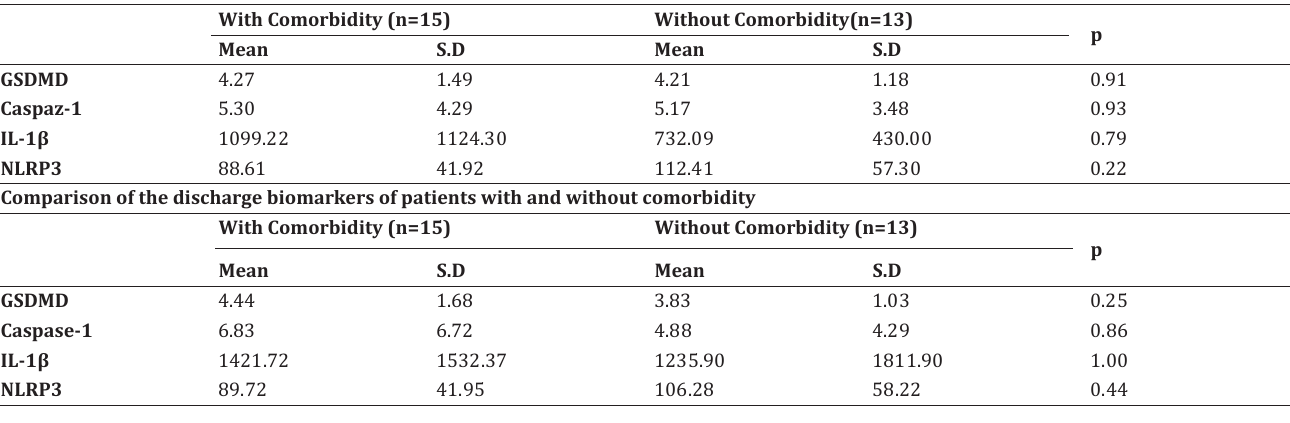
Comparison of admission and discharge day biomarkers of patients with and without comorbidity